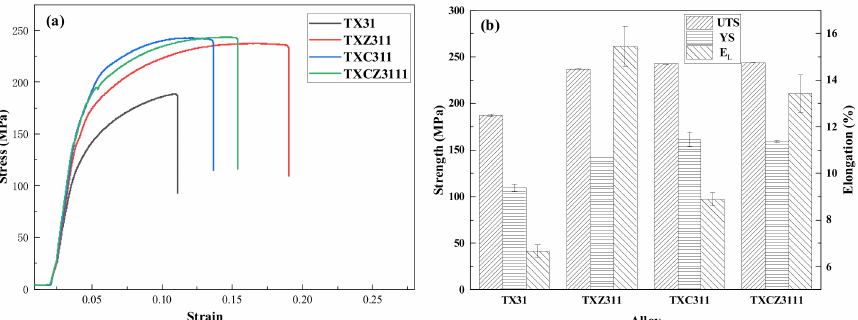
Figure 7. Mechanical properties of four extruded alloys at room temperature, ( a ) stress–strain curve; ( b ) mechanical property